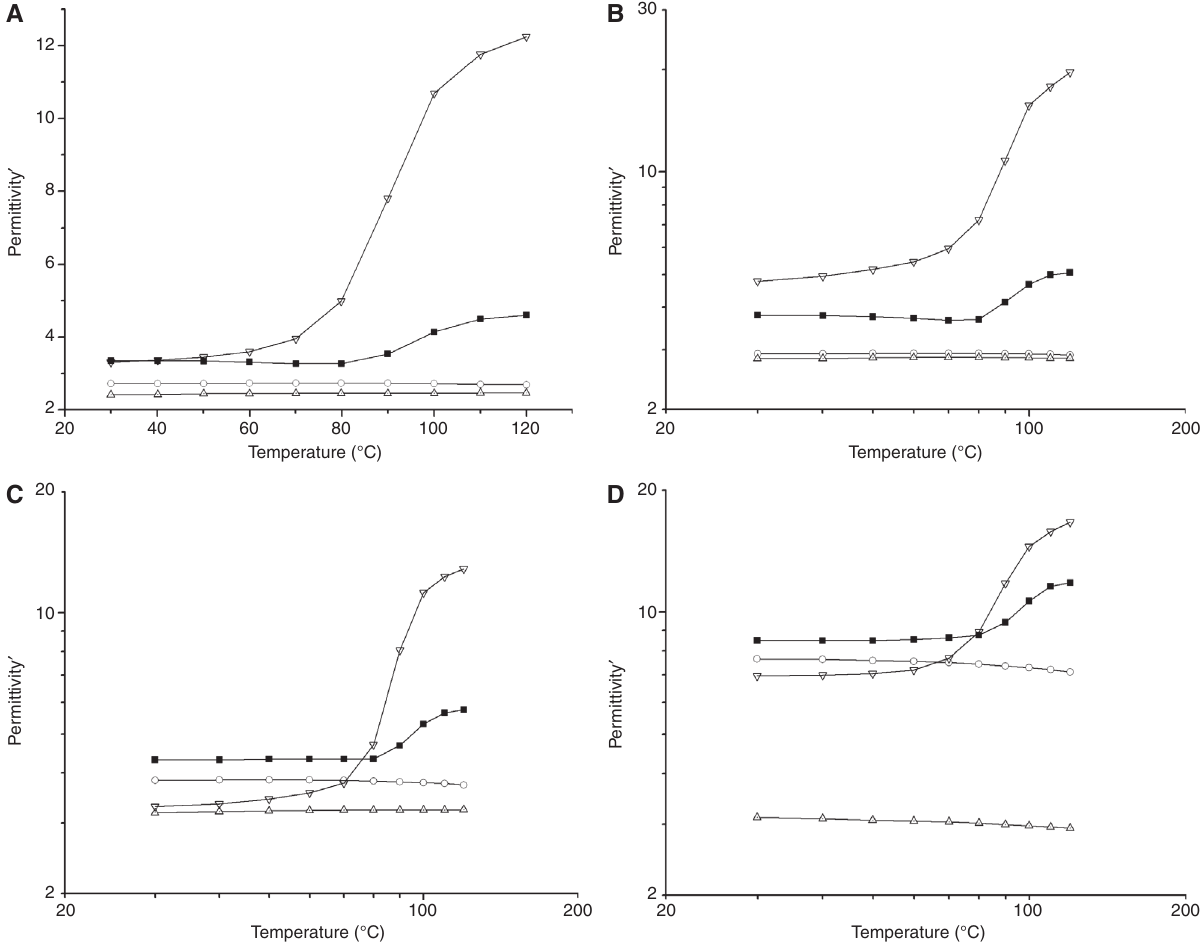
Figure 7 Dielectric permittivity ( ε ′ ) at 50 Hz related to the temperature. (A) Compound+5% GTR, (B) compound+10% GTR, (C) compound+20% GTR, and (D) compound+50% GTR: ■, EVA; ○, HDPE; ∆, PP; ,